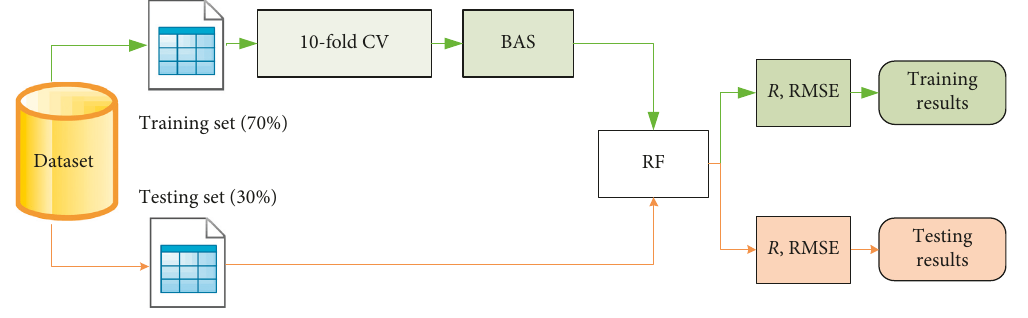
Figure 3: The flowchart of hyperparameter tuning of RF by BAS. Table 1: The input influencing variables in the BRF model.